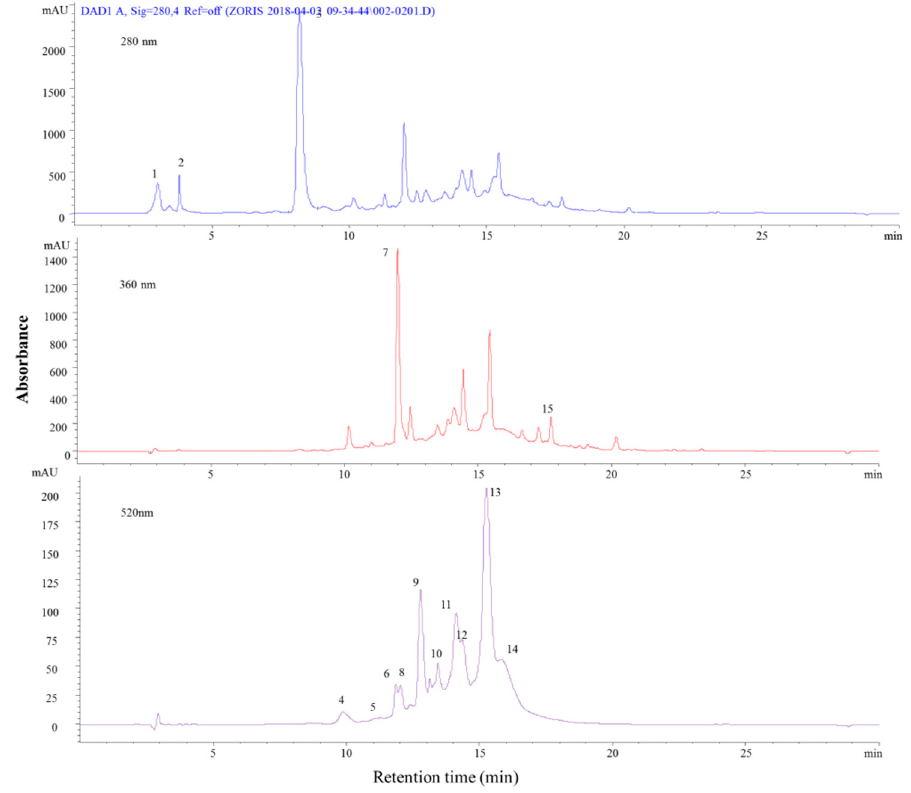
Figure 6. HPLC-PDA chromatograms of purple sweet potato recorded at 280, 360, and 520 nm. Table 6. Characterization of phenolic compounds in purple sweet potato via positive LC-MS.